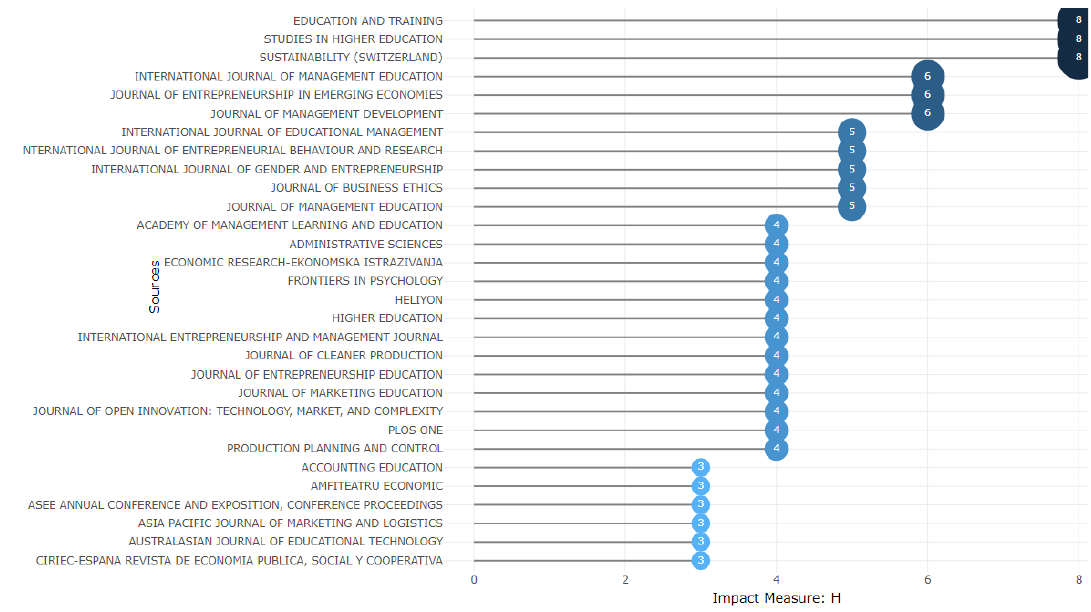
Figure 3. Source Local Impact According to the Hirsch Index